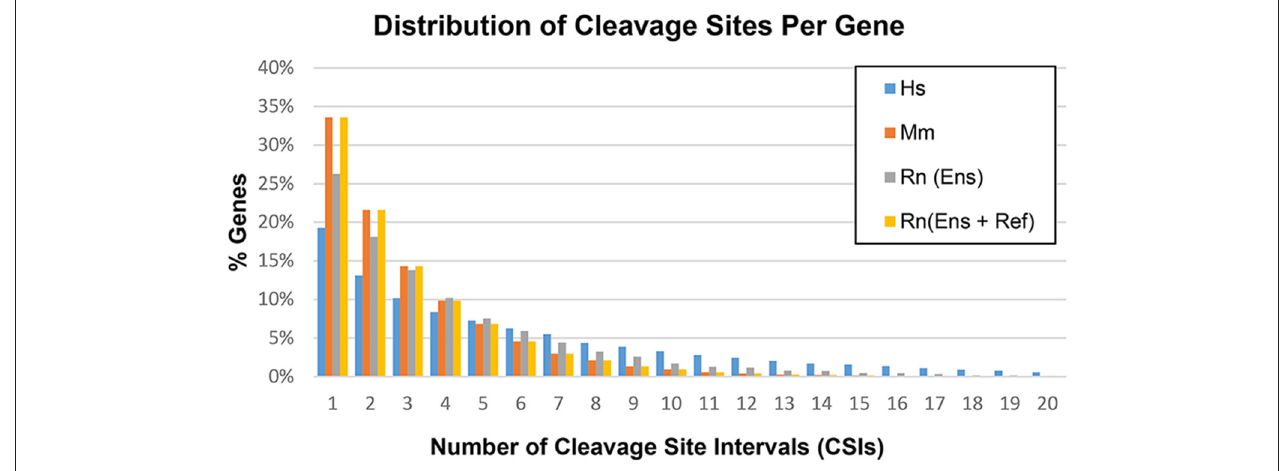
FIGURE 5 | Distribution of cleavage sites per gene in the human (Hs), mouse (Mm), and rat (Rn) transcriptomes.